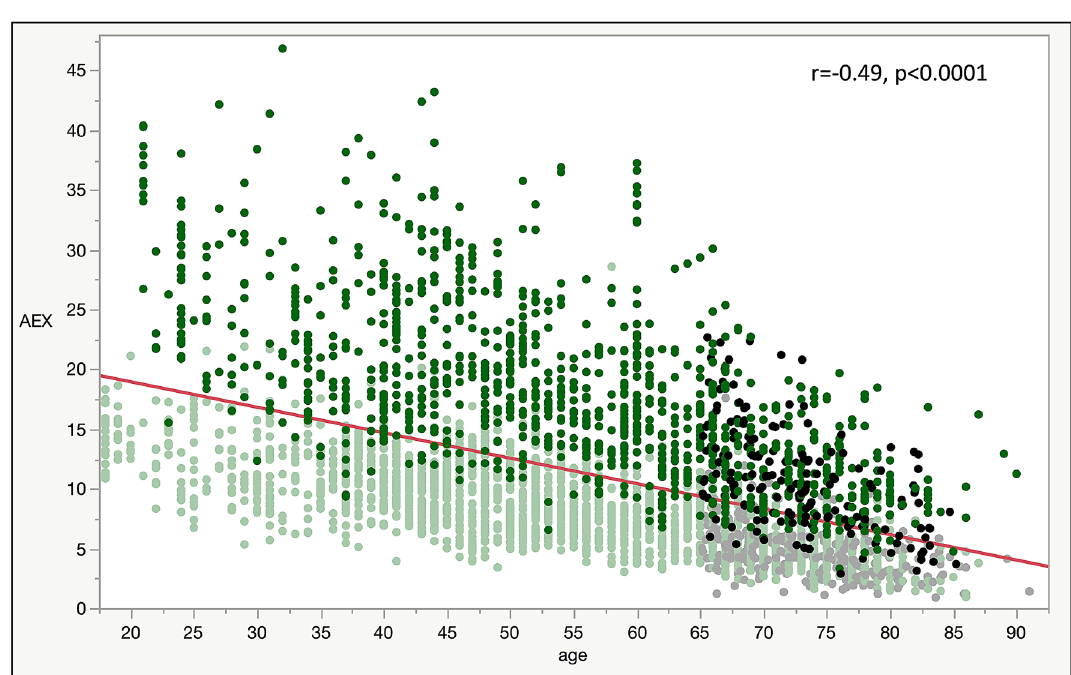
Figure 2. Bivariate linear fit by standard least square method of AEX (L 2 s −1 ) by age (years). r correlation coefficient. Color codes—green: Cleveland group; black/grey: Madrid group. Dark colors (green and black): males; light colors (green and grey):